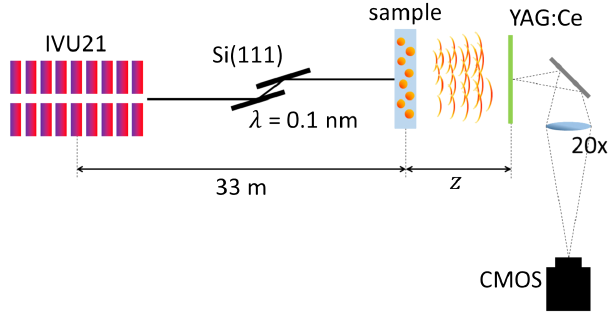
FIG. 7. HNFS experimental setup at the NCD-SWEET beam- line at ALBA.